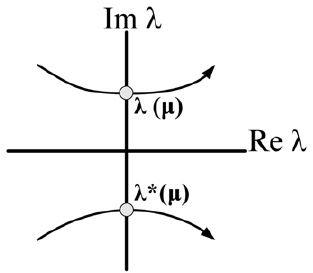
Figure 5. Locus of system’s eigenvalues during the ‘‘ birth ’’ of a limit cycle. m is defined in [40] as a bifurcation